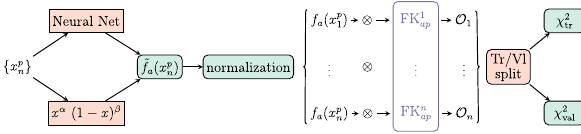
Fig. 1 Diagrammatic representation of the calculation of the χ 2 in the NNPDF fitting framework as a function of the values of { x p n } for the different datasets. Each block indicates an independent component